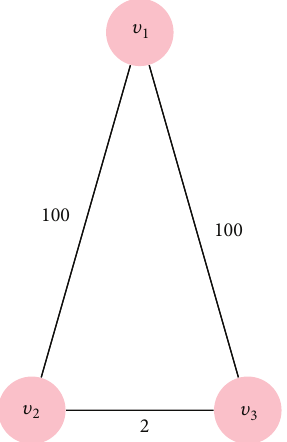
Figure 8: A network location problem for Example